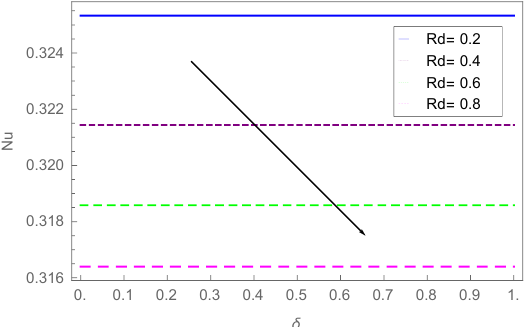
Figure 20. Graph displaying Nu dependence on Rd